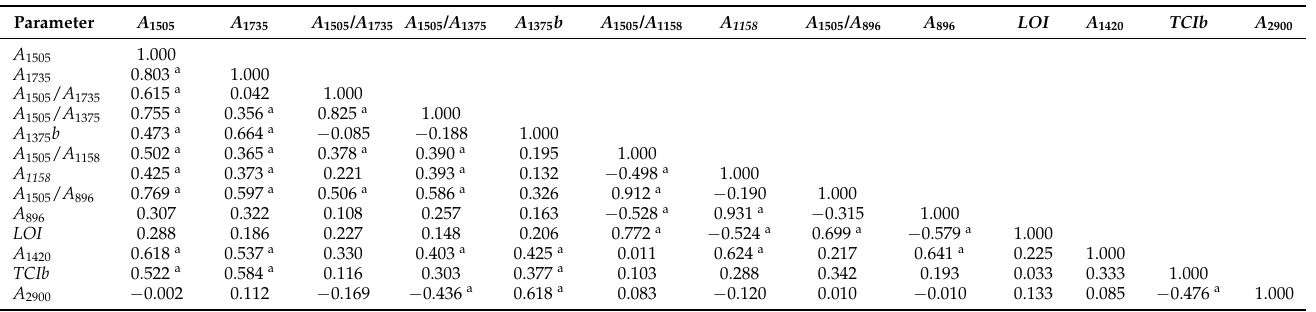
Table 3. Pearson matrix of correlation coefficients for indexes of particleboard pretreatment with P. ostreatus .